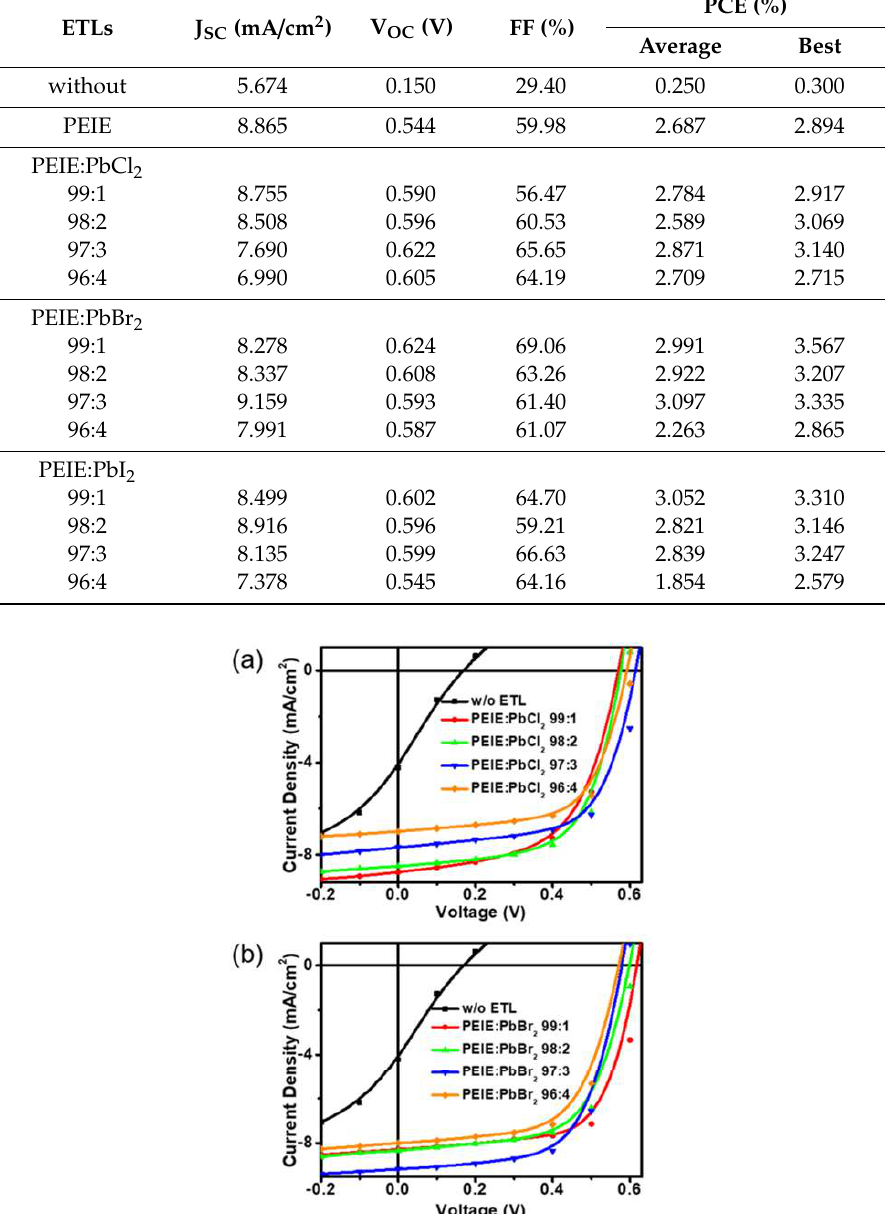
Table 1. Device characteristics of inverted poly(3-hexylthiophene):[6,6]-phenyl-C 61 -butyric acid methyl ester (P3HT:PC 61 BM) solar cells.